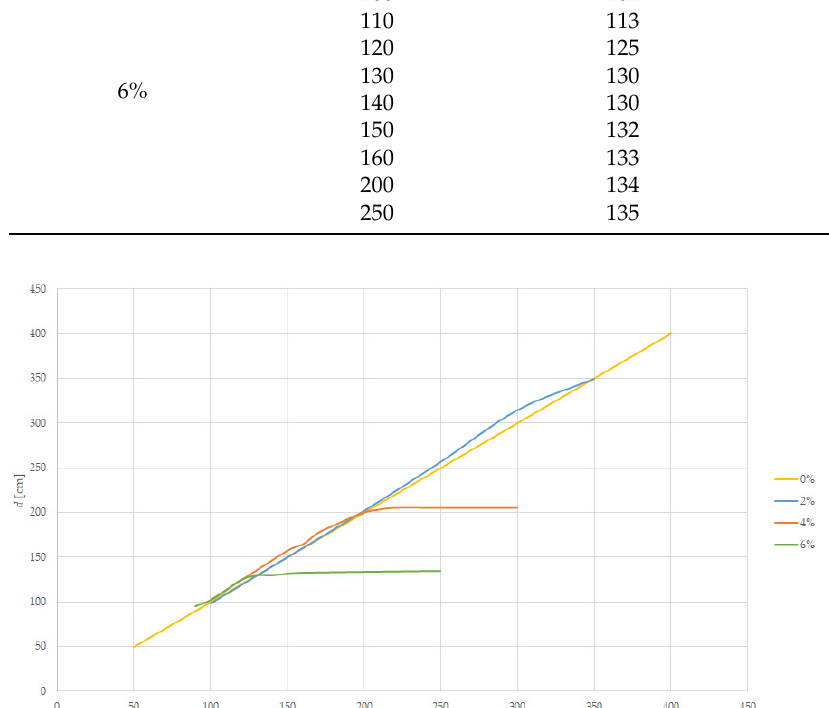
Figure 11. Distance measurement on uphill slope.